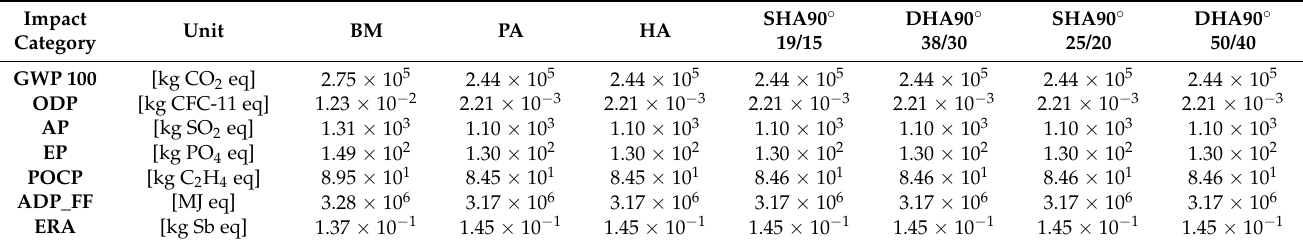
Table 7. Summary impact of sustainability indicators on the distinctive form arrangements.